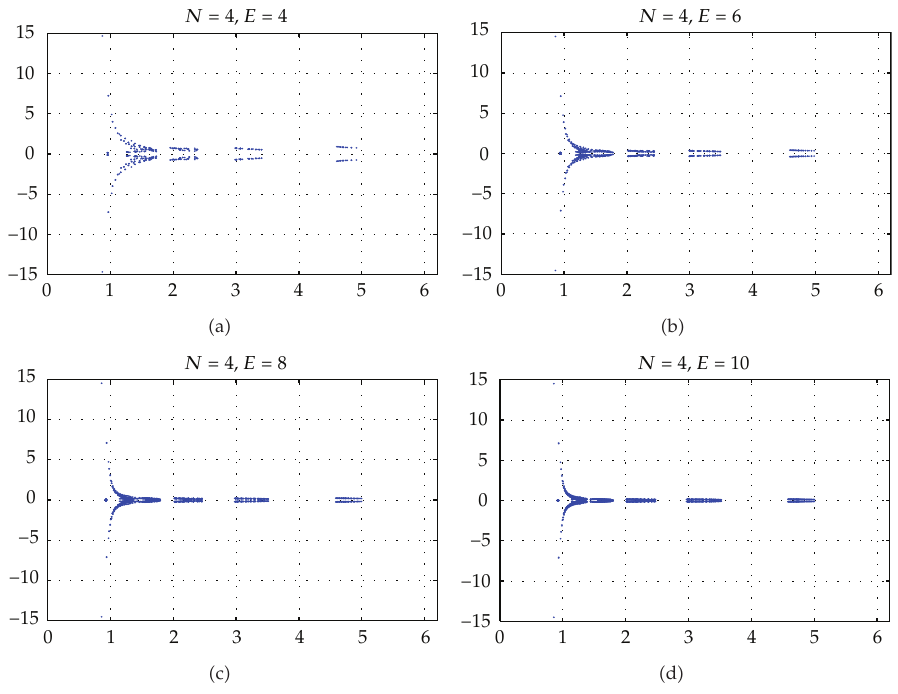
(cid:2) B − 1 (cid:2) A E (cid:2) 4 , 6 , 8 , 10 and N (cid:2) 4 when δ (cid:2) 10 − 4 , b (cid:2) (cid:5) 1 , 1 (cid:6) T . N 2 for h 2